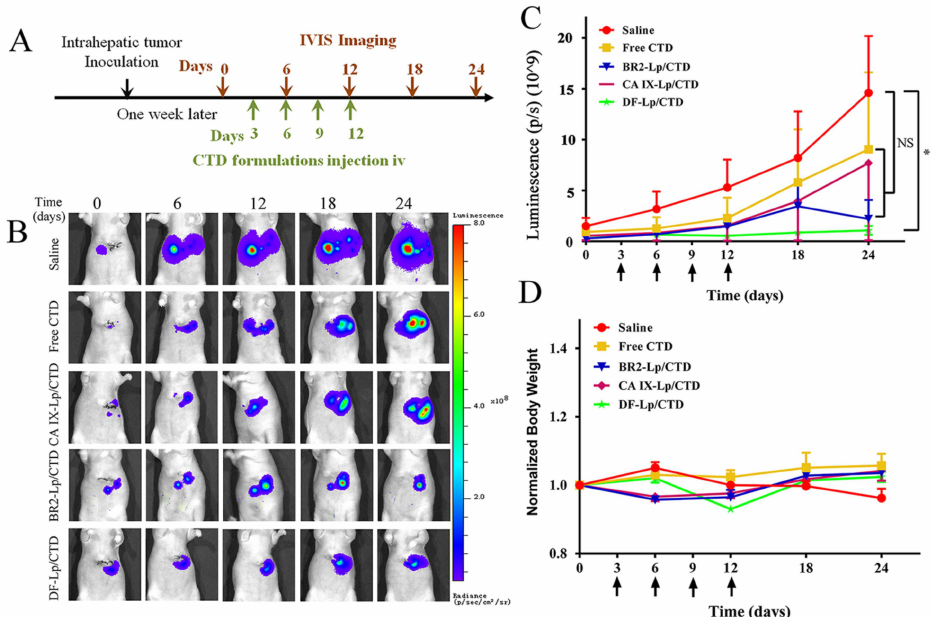
Figure 7. In vivo anticancer e ffi cacy of DF-Lp / CTD on HepG2-red-Fluc orthotopic HCC tumors. ( A ) Scheme of HepG2-red-Fluc tumor inoculation and treatment at CTD dosage of 0.4 mg / kg. ( B ) Representative live IVIS images of HepG2-red-Fluc cell-bearing tumors with administration of D-luciferin with saline-treated mice served as a control. ( C ) Quantitative measures of luminescence (mean ± SEM) of the total flux of the tumors in the mice ( n = 5). Arrows indicate drug administration time. * p < 0.05. ( D ) Bodyweight profiles of mice in di ff erent groups ( n = 5, mean ±